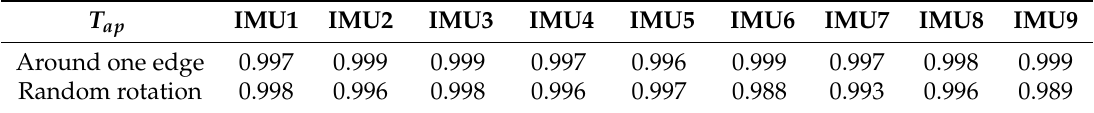
Table 5. Angular velocity correlation when attaching to an aluminum box.